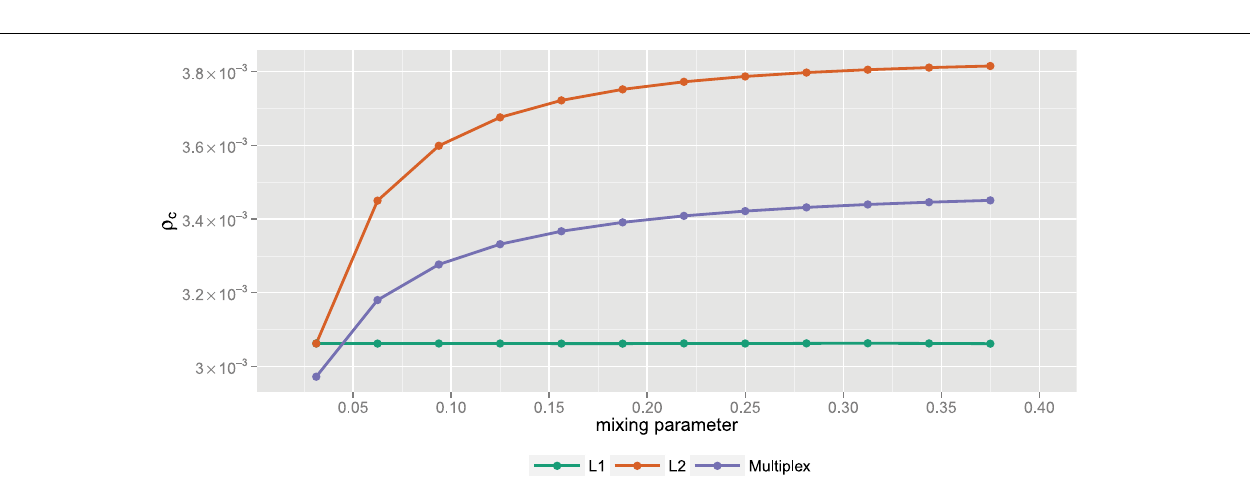
FIGURE 6 | Comparison of the critical injection rate of layer 1, layer 2 and the multiplex for different mixing parameter values and random walk routing strategy. The values of the critical injection rate for single layer network and multiplex networks are computed using Equations (1) and (2) respectively.